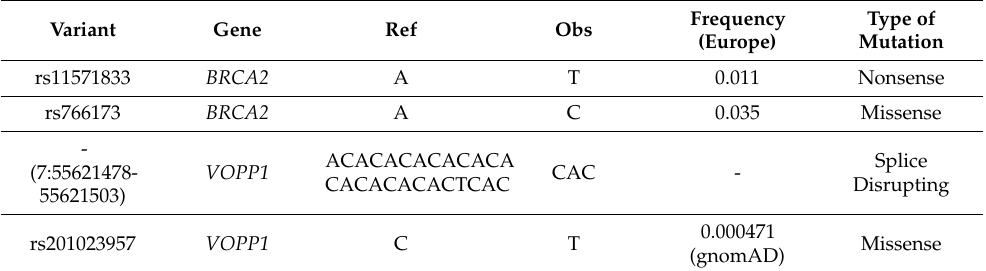
Table 2. Genes with more than two prioritized variants of different categories. Variants not found in the 1000 Genomes Project are highlighted because they were also searched in the gnomAD database. Ref; Reference allele, Obs; Observed allele.